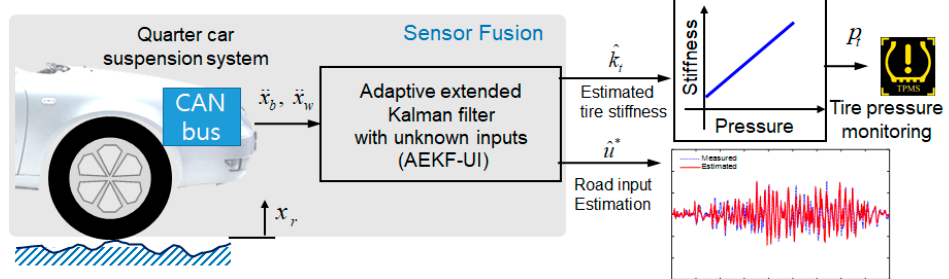
Figure 1. Overview of new indirect TPMS enabled by adaptive extended Kalman filtering of vehicle suspension systems.